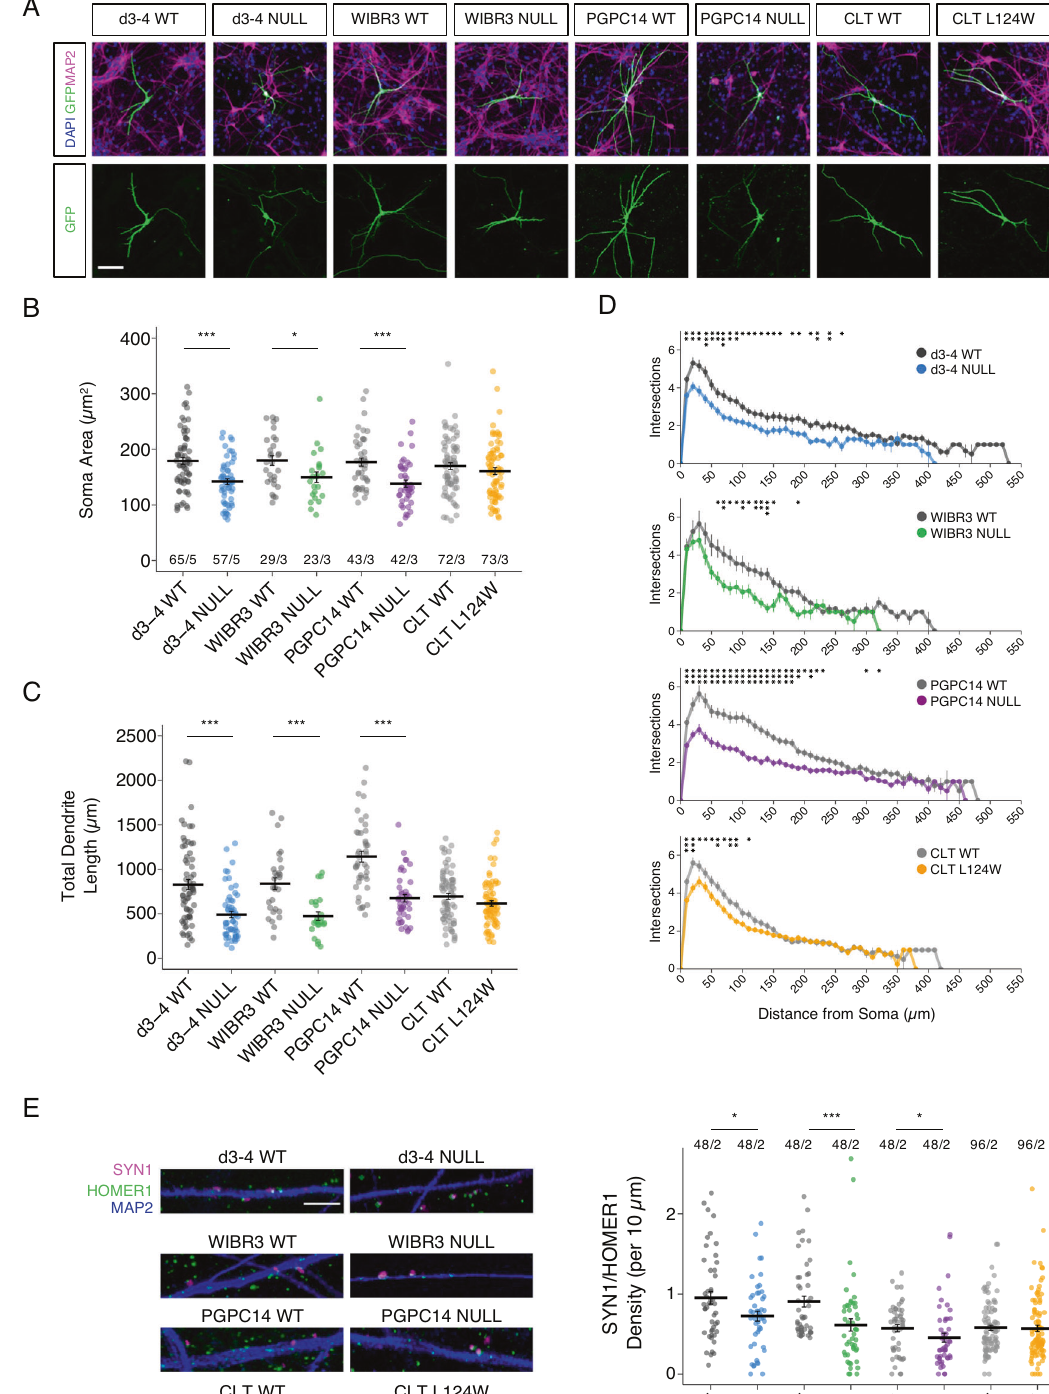
isogenic control (Fig. 5C), the WIBR3 and PGPC14 nulls were reduced in cumulative median peak bursting frequency across all timepoints. The peak bursting frequency of CLT L124W was slightly increased. Our PSD estimates consistently distinguished MECP2 null from WT Ngn2 neural networks, and captured